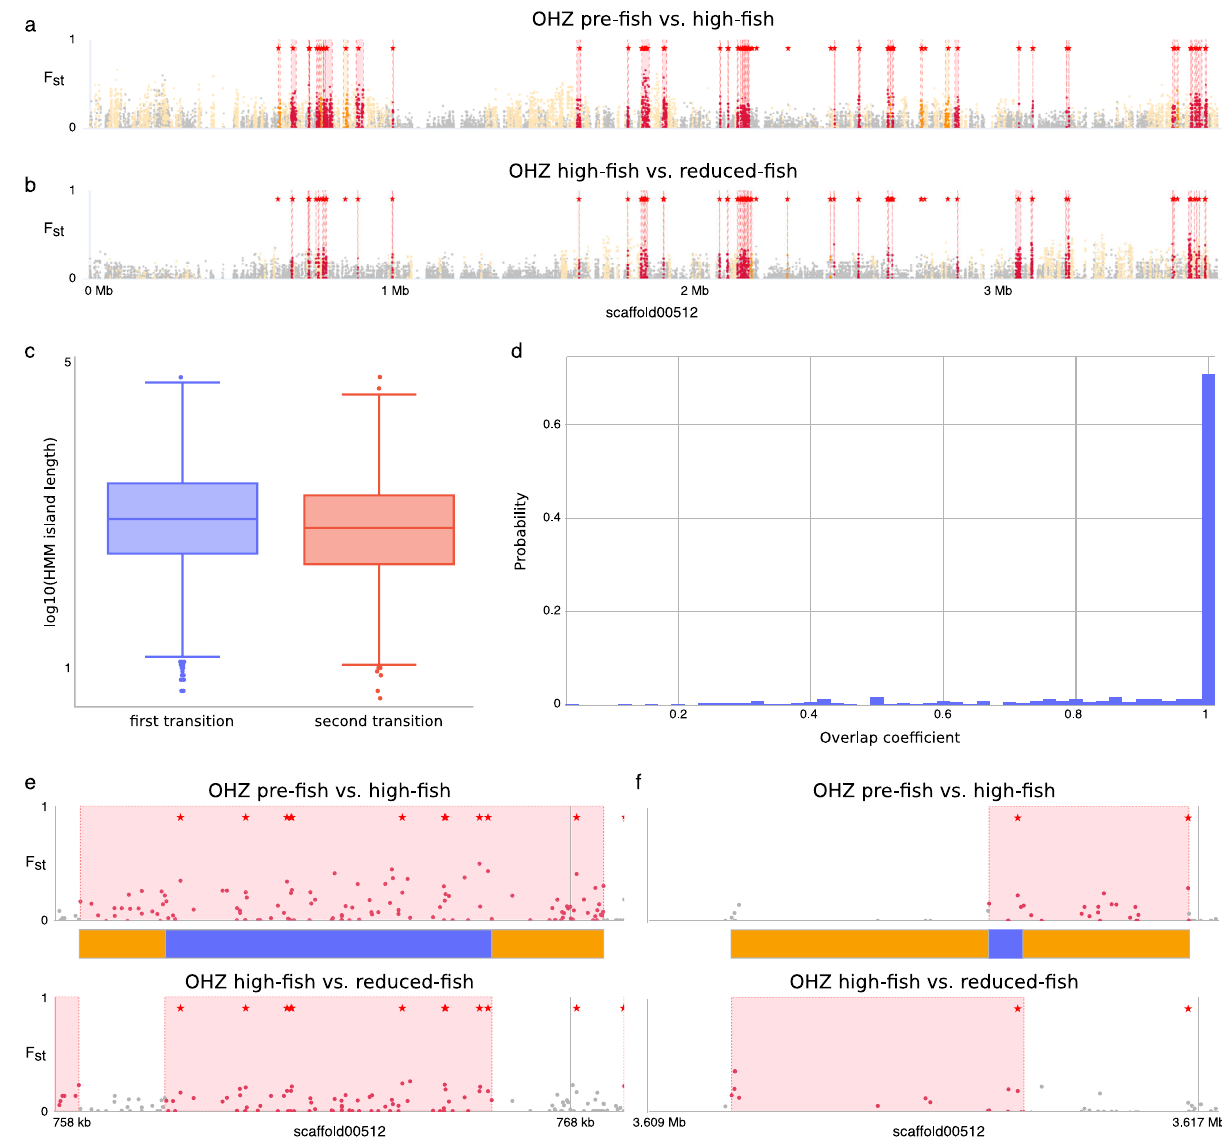
Fig. 3 Hidden Markov model SNP categories of Daphnia magna temporal subpopulations separated by time in OHZ pond in Belgium. a Genomic differentiation (F ST ) along scaffold 00512, the longest scaffold in the reassembled D. magna genome, between the pre- fi sh and the high- fi sh subpopulation. b Genomic differentiation (F ST ) along scaffold 00512 between the high- fi sh and the reduced- fi sh subpopulation. Patterns in other scaffolds are similar. c Box-plots showing the signi fi cant reduction (Mann – Whitney U test, upper tailed, statistic = 173,517.5, P value = 9.78E-20) in average length of HMM- detected islands of divergence between the pre- fi sh to high- fi sh ( n = 6111;minima: 0.70, maxima: 4.80, center: 2.95, Q1: 2.50, Q3: 3.41; lower fence: 1.15, upper fence: 4.73) and high- fi sh to reduced- fi sh ( n = 2879; minima: 0.60, maxima: 4.81, center: 2.83; Q1: 2.36, Q3: 3.26; lower fence: 1.04, upper fence: 4.58), outliers are de fi ned as the data points more than three times of the interquartile range above Q3 or below Q1 transitions. d Histogram representing the overlap coef fi cient for all the overlapping HMM-detected islands of high divergence. The high values for the overlap coef fi cient suggest a high overlap between the islands of divergence between the two transitions. e An example illustrating the reduction in length of a HMM-detected island of divergence from the larger island of divergence in the pre- fi sh to high- fi sh transition (top) to a substantially smaller island in the high- fi sh to reduced- fi sh transition (bottom). f Example of reshuf fl ing of a HMM-detected island of divergence in the pre- fi sh to high- fi sh transition (top) to the high- fi sh to reduced- fi sh transition (bottom). The stars in plots a , b and e , f indicate outlier SNPs. Red regions in plots a , b indicate overlapping islands of high divergence, whereas yellow regions indicate nonoverlapping (i.e., transition-speci fi c) islands of high divergence. The pink boxes in plot e , f demarcate the HMM-detected island of divergence. The blue and orange boxes in plots e , f demarcate regions that harbor SNPs that are likely targeted by selection, or that are likely impacted by hitchhiking,